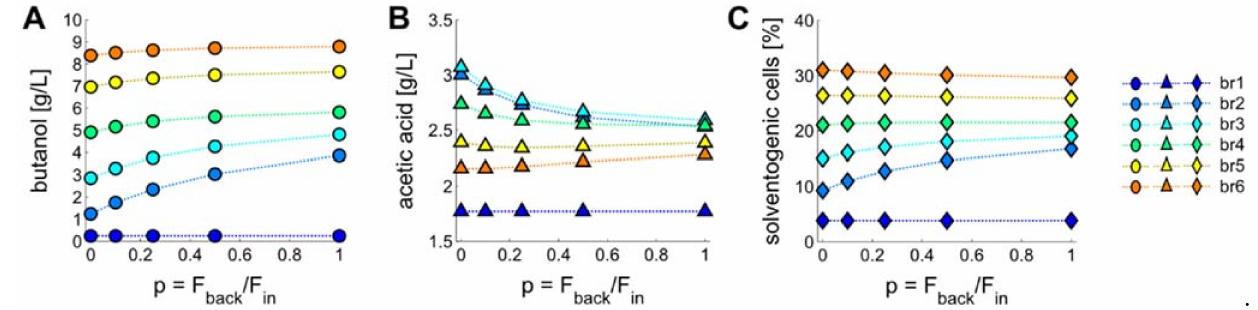
Figure 7. Simulation of butanol ( A )/acetic acid ( B ) concentrations and proportions of solventogenic cells ( C ) along the cascade in dependency of the feedback flow F back . F in was kept constant at 0.22 L h − 1